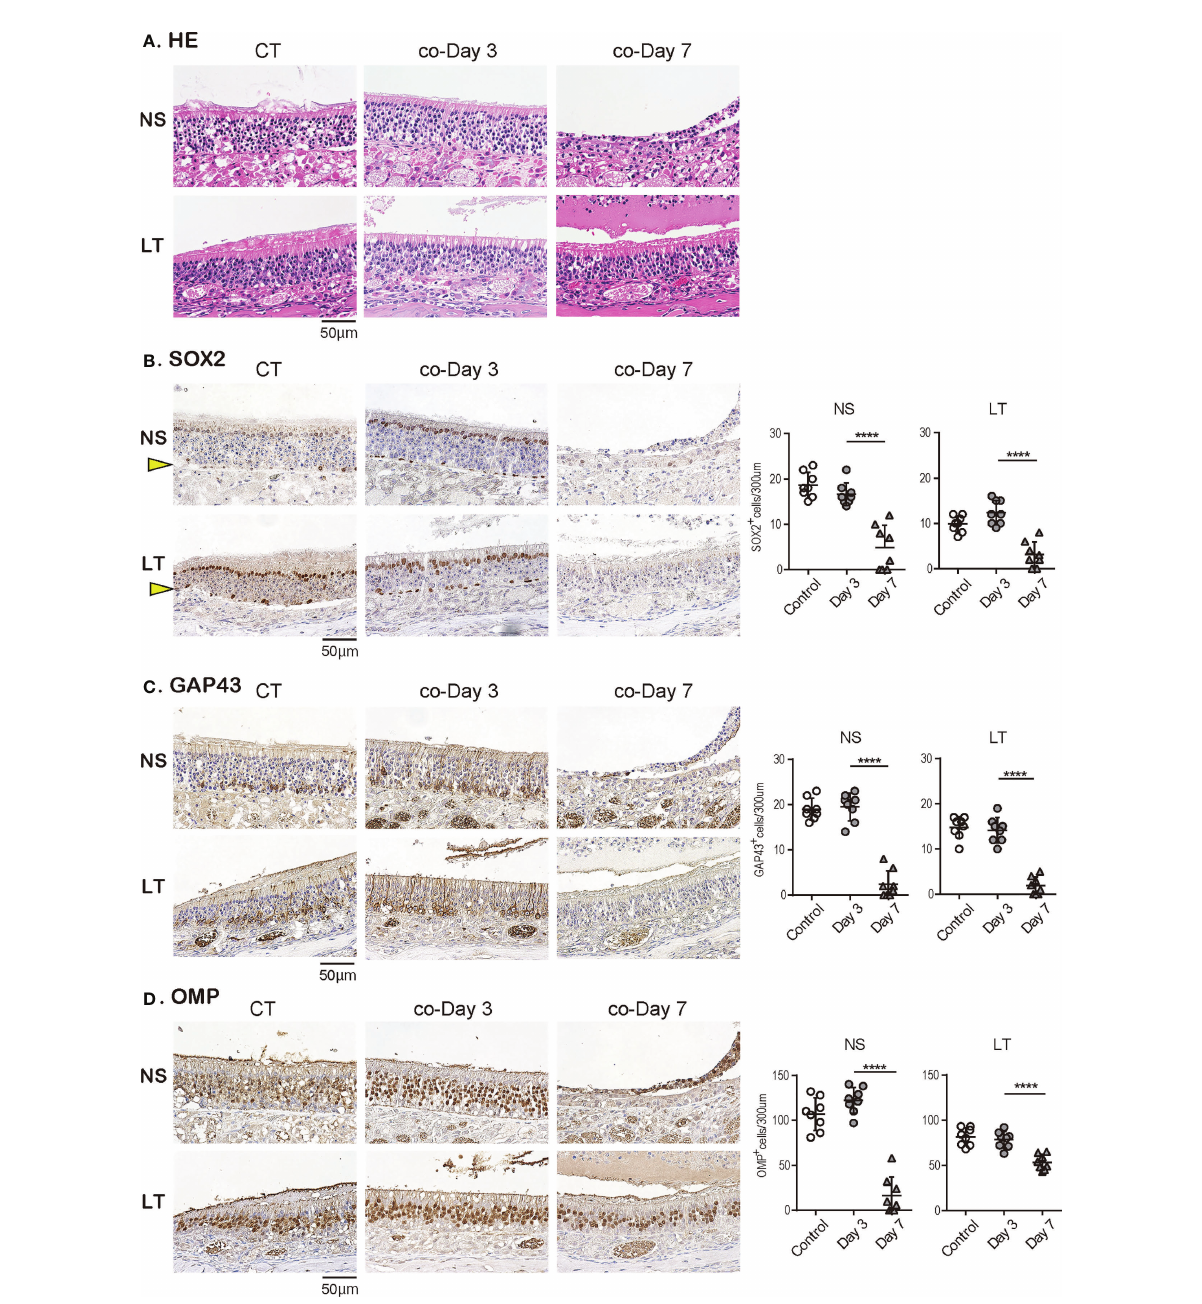
FIGURE 5 Effects of SARS-CoV-2 on the olfactory receptor neuron lineage after short-term close contact. (A) Representative hematoxylin and eosin staining (HE) images of the olfactory epithelium in control (CT) hamsters and contact hamsters on days 3 and 7 (co-Day 3, co-Day7). (B – D) : Representative images of immunohistological staining. The nasal septum (NS) area and lateral turbinate (LT) area are shown in magni fi ed view. Sex-determining region Y-box 2 (SOX2) + progenitor cells (B) , growth-associated protein 4 (GAP43) + immature olfactory receptor neurons (ORNs) (C) , and olfactory marker protein (OMP) + ORNs (D) are shown in brown. The basal layer is indicated by arrows. Tissue sections were counterstained with the nuclear dye hematoxylin (blue). Numbers of SOX2 + ORN progenitors per 300 m m of the basal layer and GAP43 + immature ORNs and OMP + mature ORNs per 300 m m of olfactory epithelium in each area are counted in CT or contact hamsters. **** P < 0.0001. SARS-CoV-2, severe acute respiratory syndrome coronavirus